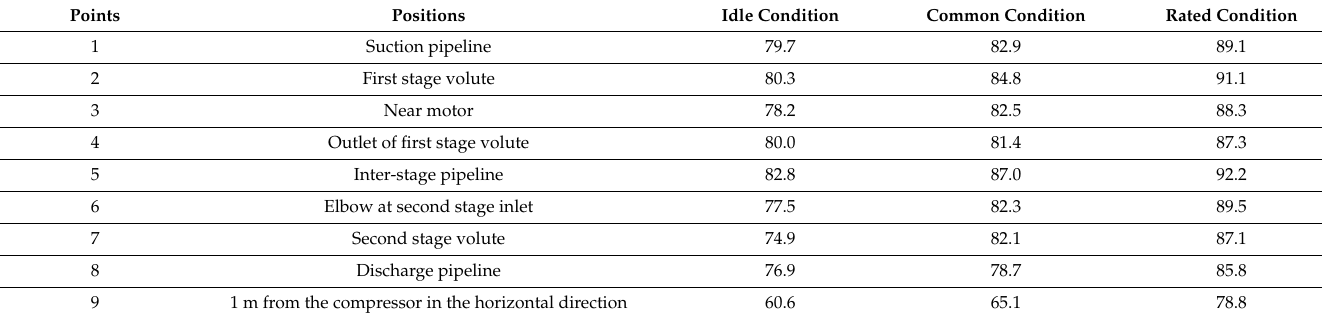
Table 4. Sound pressure level at measuring points [dBA].